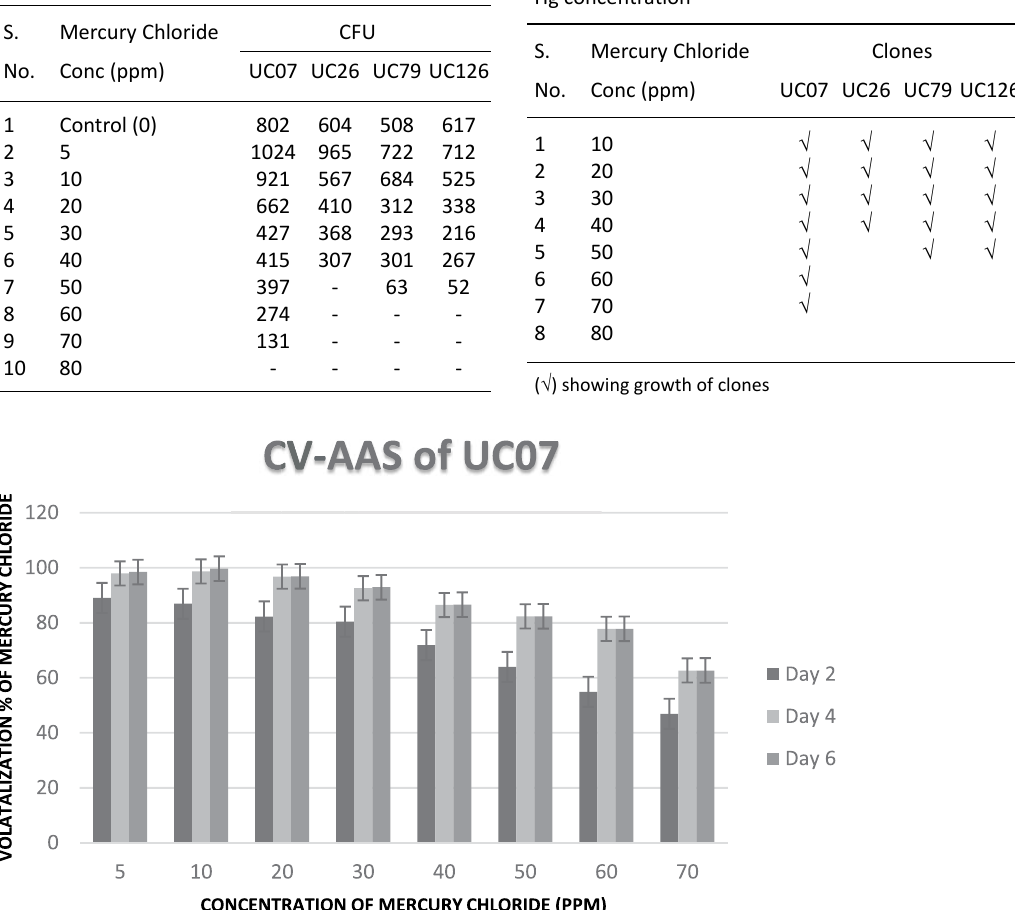
Fig. 3. Mercury bioconversion (%) by UC07 clone on day 2, 4 and